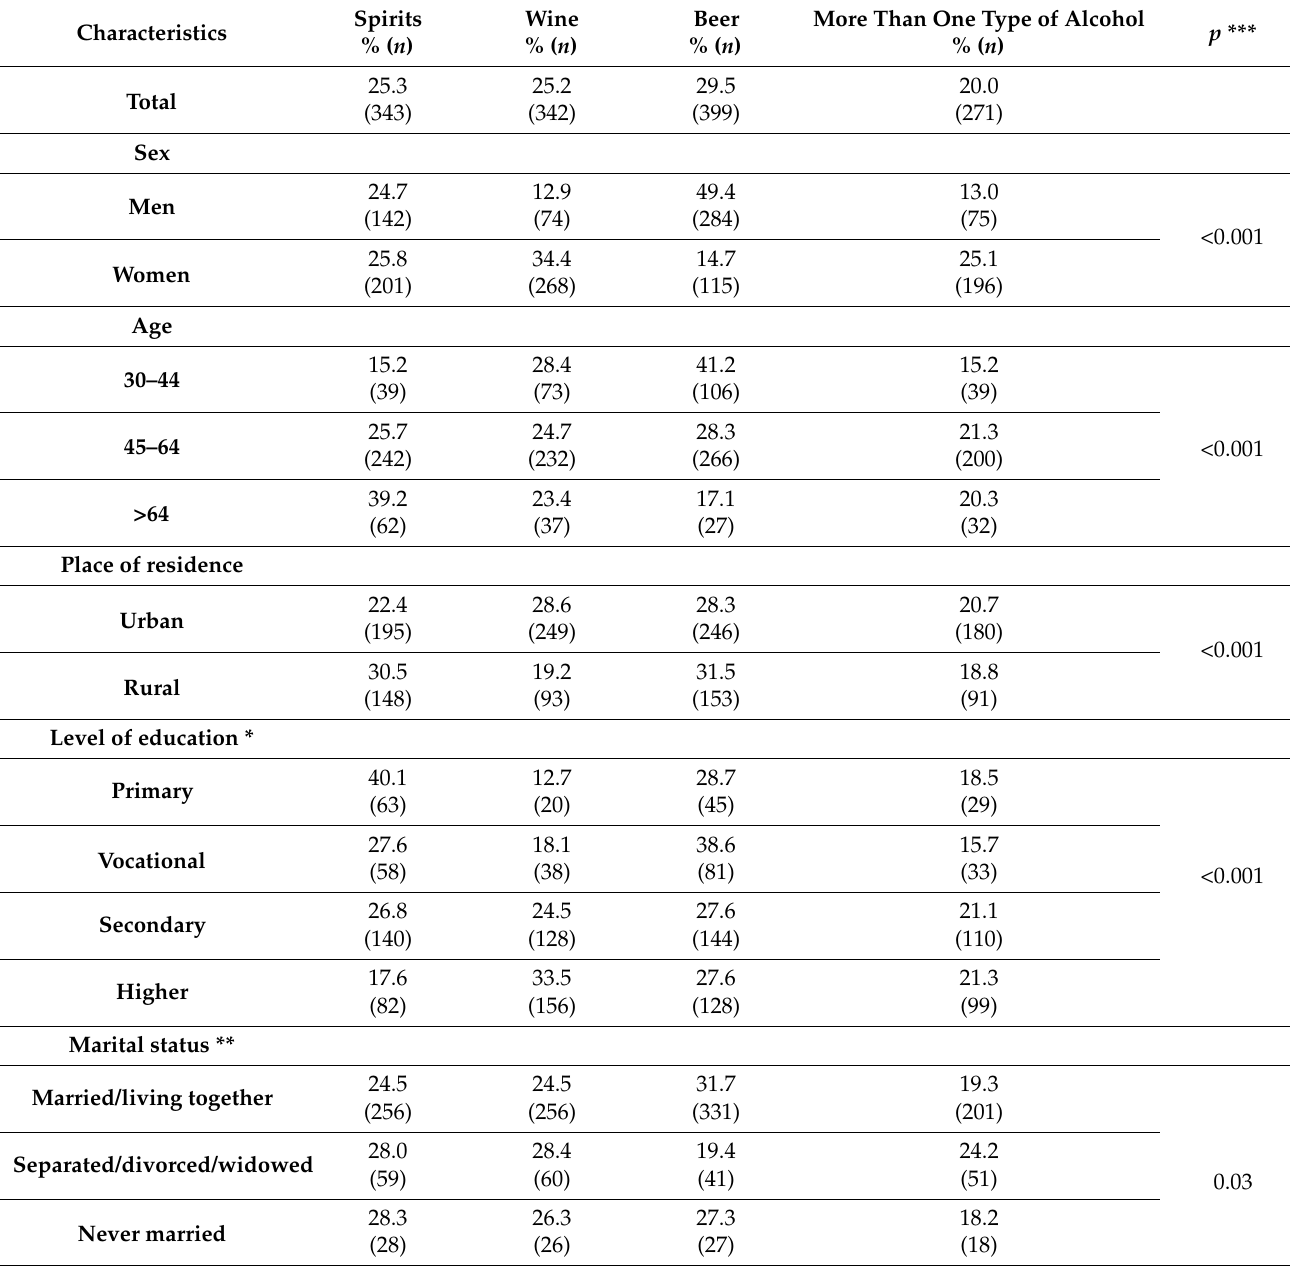
Table 4. The baseline characteristics of the types of alcoholic beverages most frequently consumed by participants who declared current use of alcohol